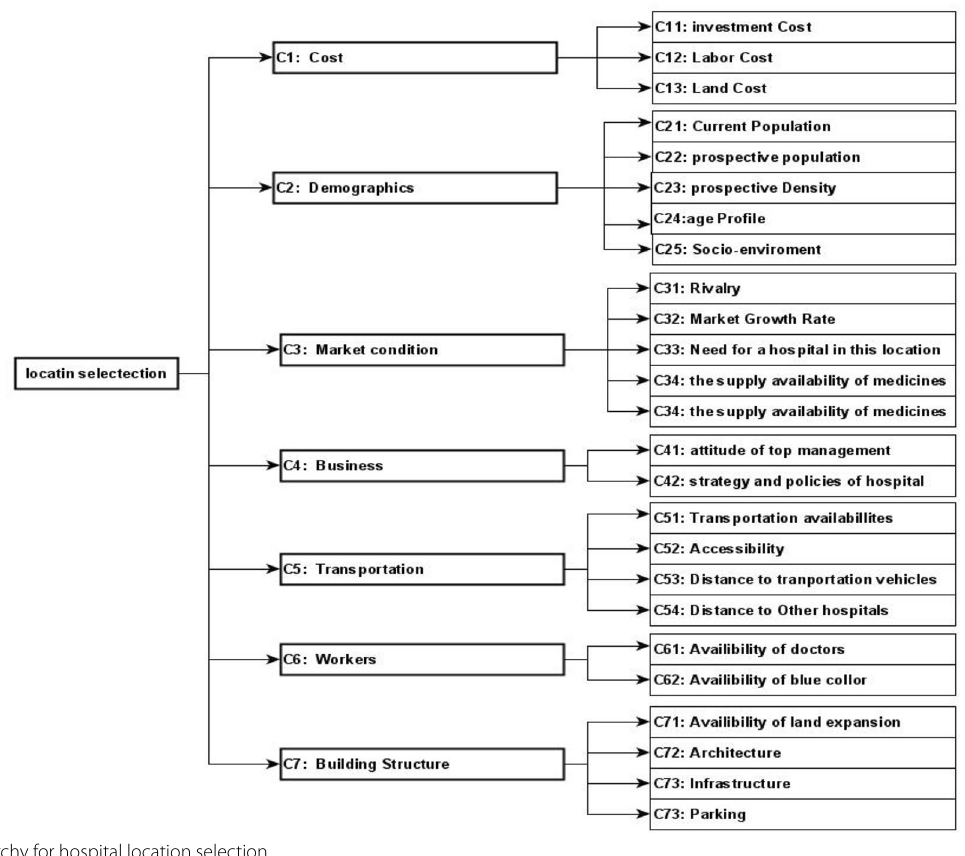
Fig. 3 Hierarchy for hospital location selection